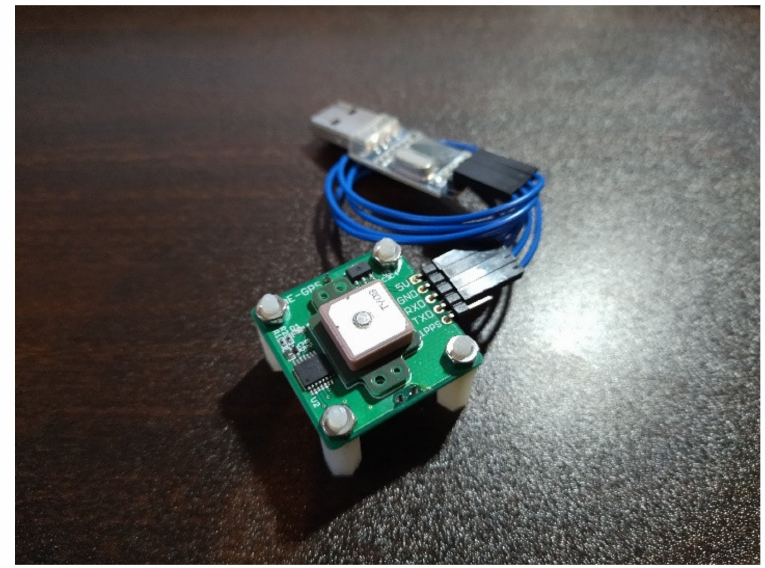
Figure 4. A GPS receiver kit sold by Akizuki Denshi Tsusho [5].